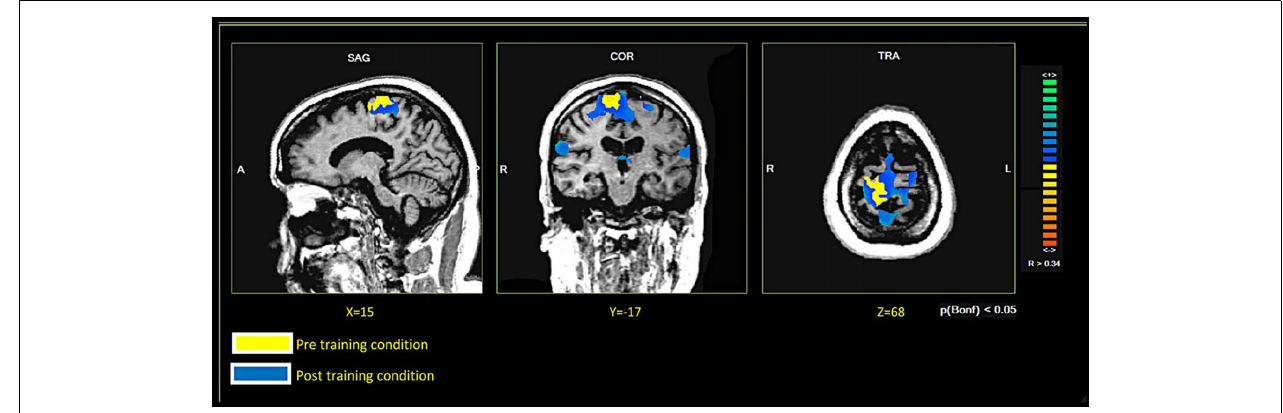
FIGURE 5 | Brain connectivity in the pre- and post-training conditions: patient